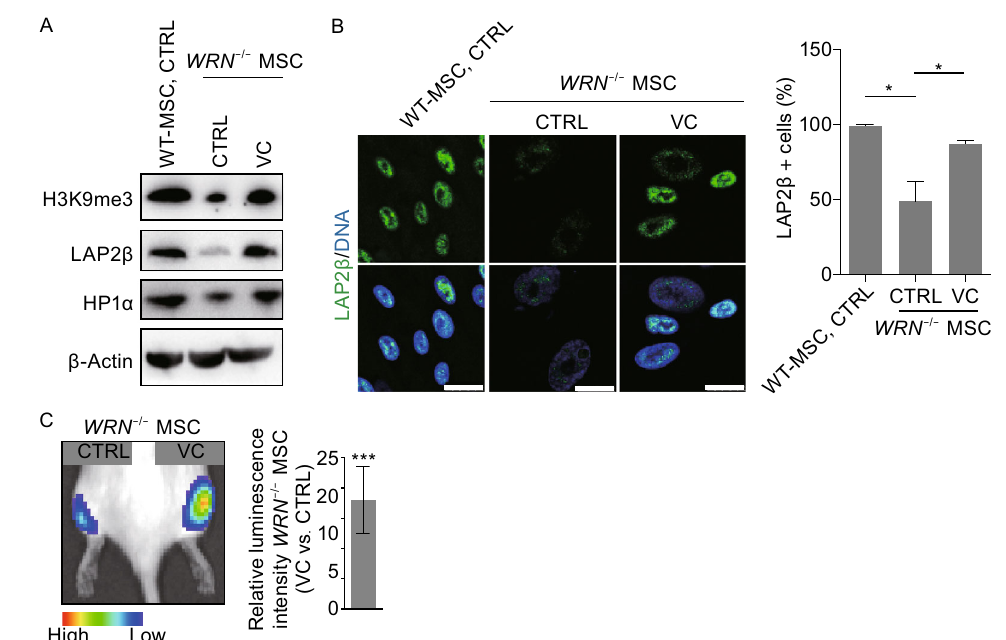
Figure 3. VC restores epigenetic parameters and in vivo viability of WS MSCs. (A) Western blot analysis of the indicated proteins in MSCs. (B) VC increased heterochromatin markers by immuno fl uorescence staining. Representative immuno fl uorescence staining (left) and quantitative analysis (right) of LAP2 β in vehicle or VC treated (7 days) WT MSCs and WRN -/- MSCs. Scale bar, 25 µm. (C) Luciferase activity of WS MSCs was detected by in vivo imaging system (IVIS) one week after implantation, and quantitative results were shown on the right. All data are represented as mean ± SEM. * P < 0.05, *** P < 0.001 by t test; n